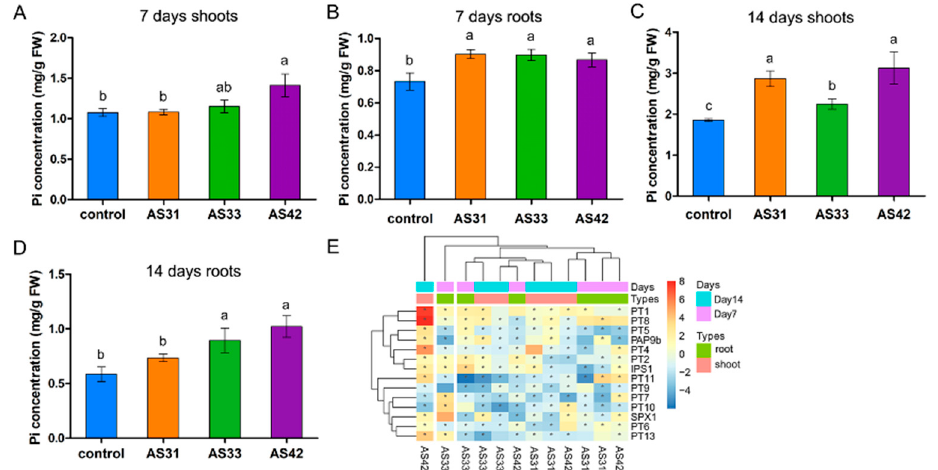
Figure 7. Pi accumulation and expression of Pi transport-related genes in rice in response to the inoculation of strains AS31, AS33, or AS42 after 7 and 14 days. ( A , B ) Pi concentrations in shoots ( A ) and roots ( B ) of rice inoculated with each strain after 7 days; ( C , D ) Pi concentrations of shoots ( C ) and roots ( D ) of rice inoculated with each strain after 14 days. Different letters indicate significant differences according to Duncan’s multiple range test. Values of p < 0.05 are considered significant. ( E ) heat map showing the expression (log2-fold change of inoculated vs. uninoculated samples) of Pi transport-related genes in both the roots and shoots of rice at 7 and 14 days after inoculation with strains AS31, AS33, or AS42. The gene expression was obtained by quantitative real-time PCR (qRT-PCR), and the primers used in the qRT-PCR are listed in Table S1. Red, increase in gene expressions; blue, decrease in gene expressions. Asterisks indicate significant differences ( p <